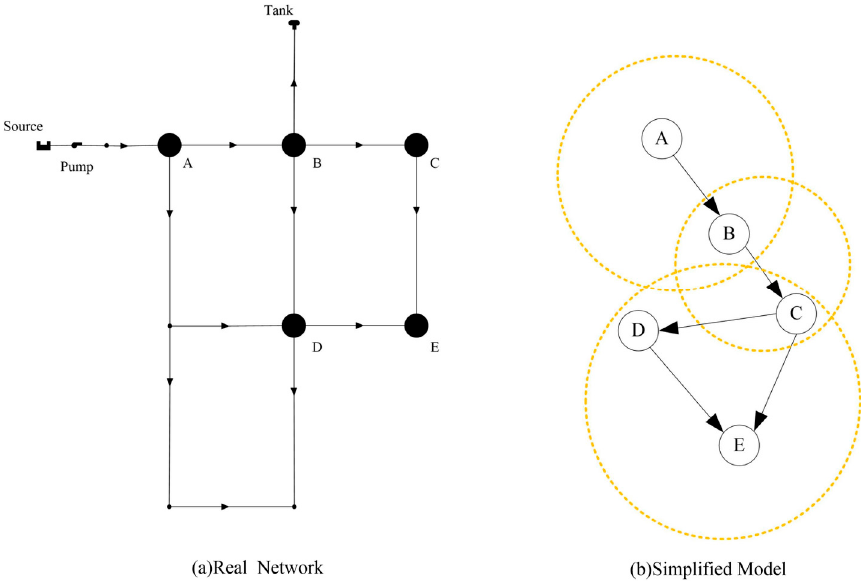
Figure 3. Real Network and a simplified model network in Case1. ( a ) is the real network of a water distribution system, and ( b ) is a simplified model consisting of five monitoring stations. A–E are five different stations in the network.